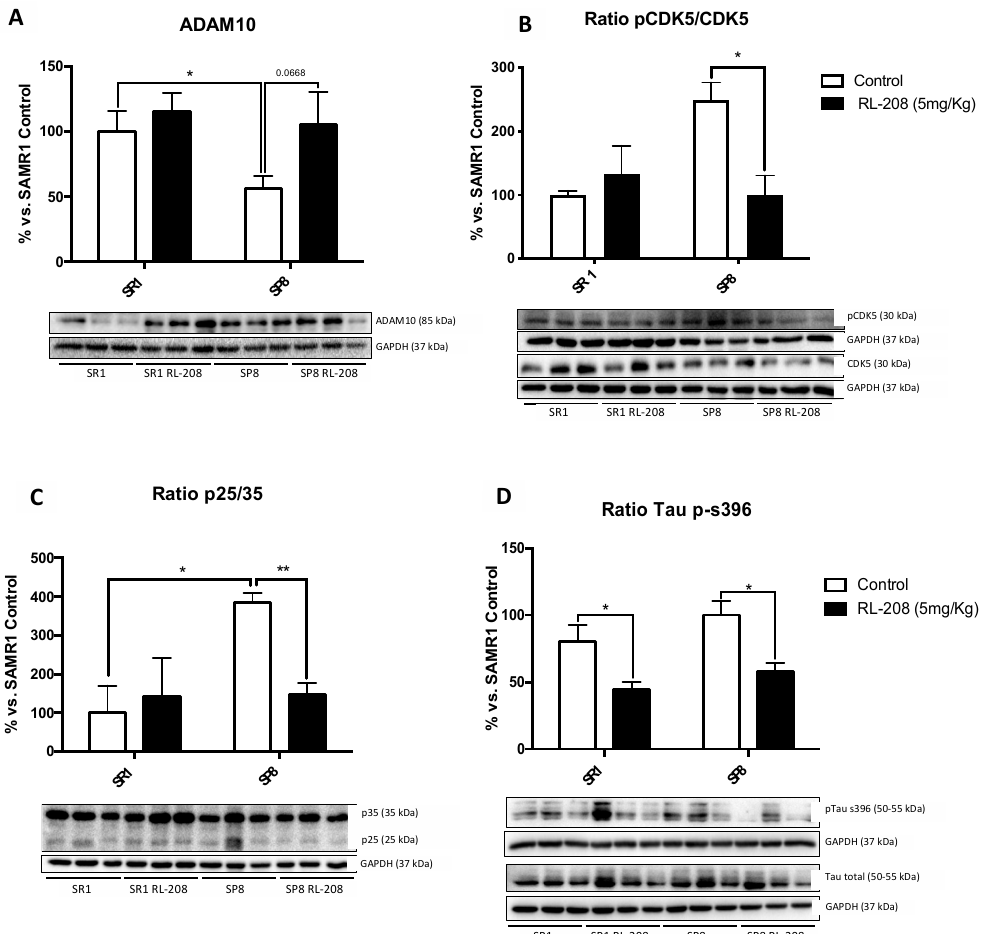
Figure 7. Representative Western Blot and quantifications for ADAM10 ( A ), ratio p-CDK5 / CDK5 ( B ), ratio p25 / p35 ( C ), and ratio Tau (p-s396) ( D ). Values in bar graphs are adjusted to 100% for protein levels of the control SAMR1 (SR1 Ct). Values represented are mean ± Standard error of the mean (SEM); (n = 6 for each group). * p < 0.05; ** p <